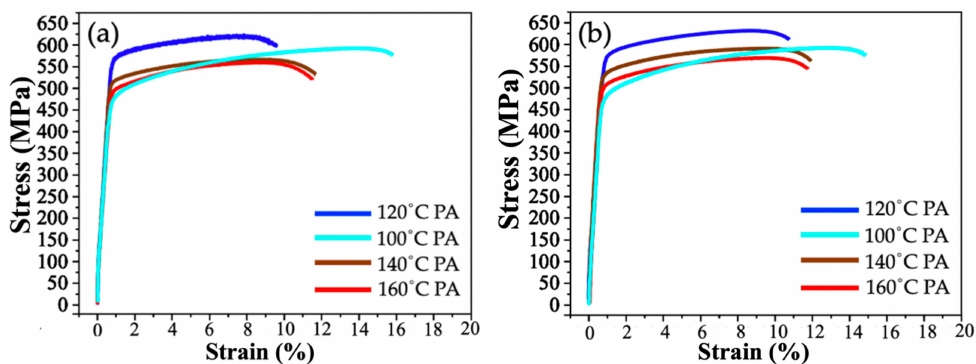
Figure 3. Stress-strain curves for ( a ) 7075-LCu and ( b ) 7075-HCu subjected to different PA treatments. Table 2. Mechanical properties of 7075-LCu subjected to different PA treatments. Aging Temp.